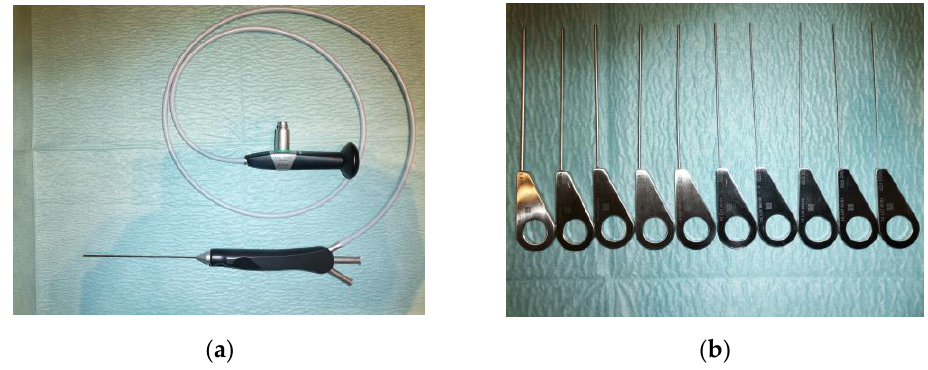
Figure 3. Sialendoscope and probes used for dilatation of papilla. ( a ) displays a sialendoscope (Karl Storz, Tuttlingen, Germany). In ( b ), dilatation probes (Marchal dilatator system, Karl Storz, Tuttlingen, Germany) with sizes in decreasing order are depicted (from size 6 to 0000).